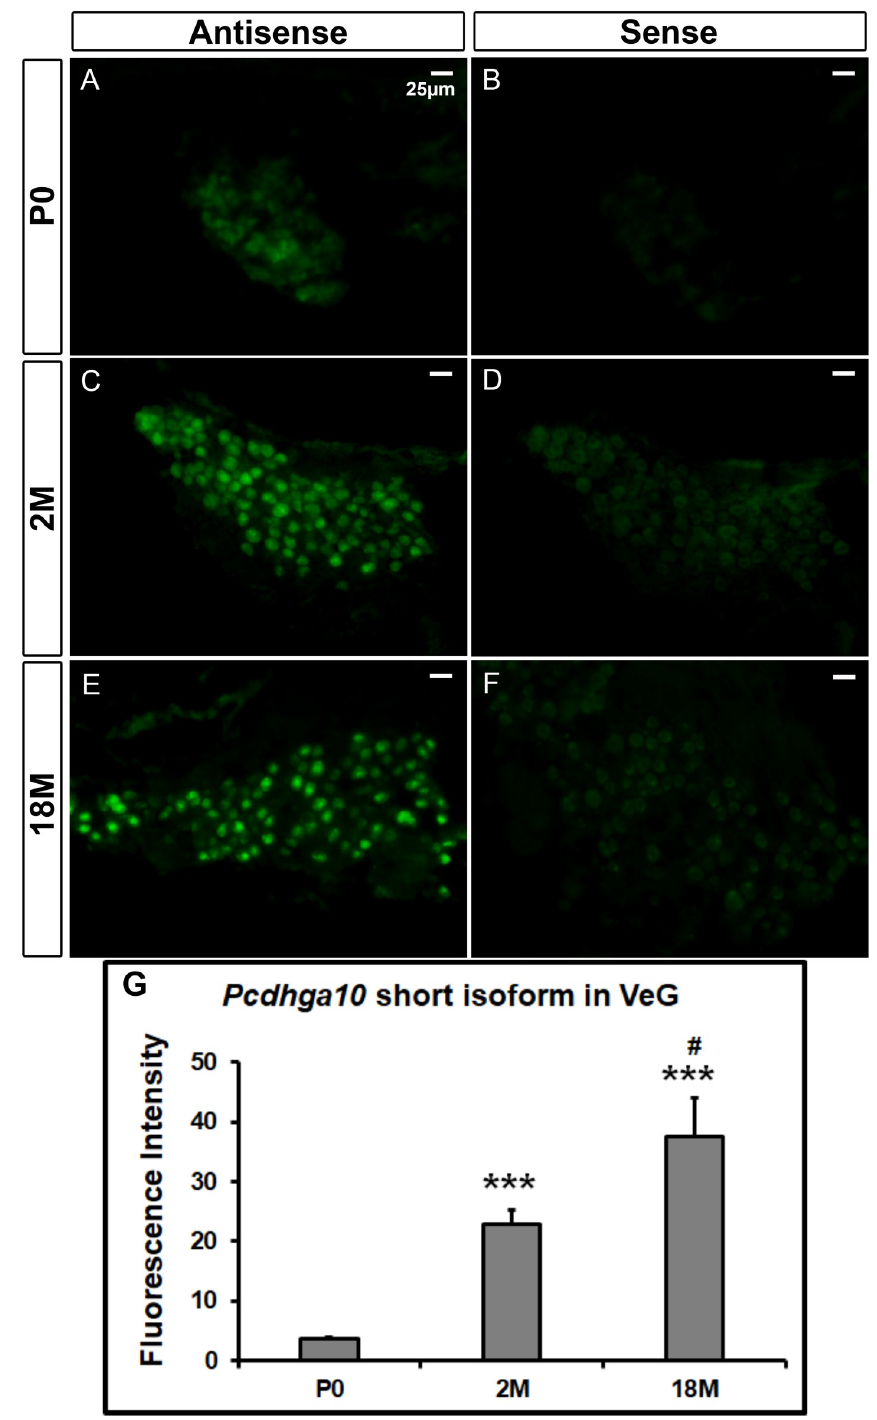
Fig 6. Fluorescent in situ hybridization of the short isoform of Pcdhga10 mRNA in mouse vestibular ganglia. Fluorescent signals of the antisense probe of the short isoform increase with age, whereas signals of the negative controls are at background levels. P0, postnatal day 0; 2M and 18M, 2 and 18 months old, respectively. VeG, vestibular ganglia. Scale bar, 25 μ m. ��� denotes p < 0.001 when compared with P0, # denotes p < 0.05 when the 2M group is compared with 18M (n = 4